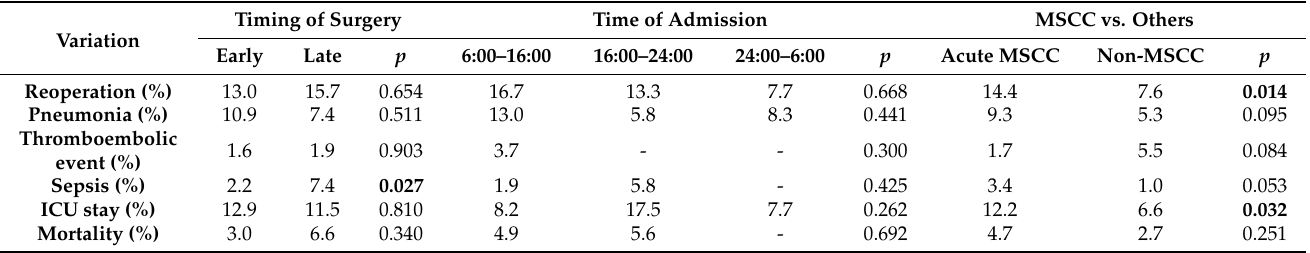
Table 5. Complication rates after surgery, stratified by timing of surgery, time of admission and for acute MSCC versus non-MSCC patients. ICU—intensive care unit; bold typeface denotes statistically significant